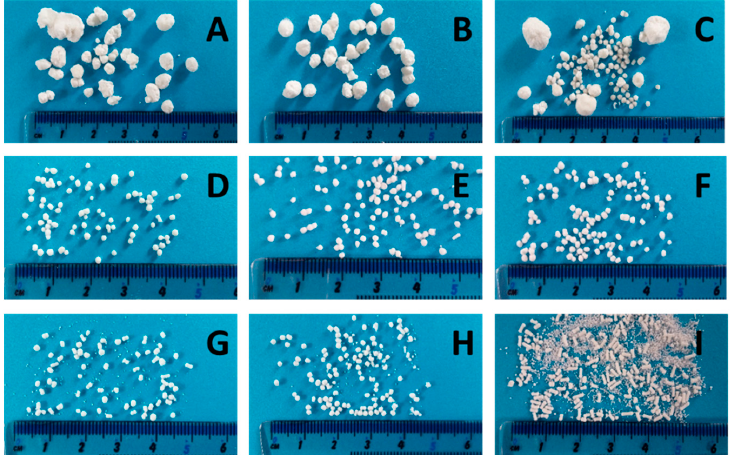
Figure 2. NAM-MCC pellets (80%:20%) after extrusion and spheronisation (3 min, 15 g) with different solid feed rates (g/min): 5.3 ( A ), 5.5 ( B ), 5.6 ( C ), 6.2 ( D ), 6.4 ( E ), 6.6 ( F ), 6.7 ( G ), 7.4 ( H ), 7.9 ( I ). The granulating liquid was distilled water with a constant feed of 1.74 g/min. Pharmaceutics 2019 , 11 , x FOR PEER REVIEW